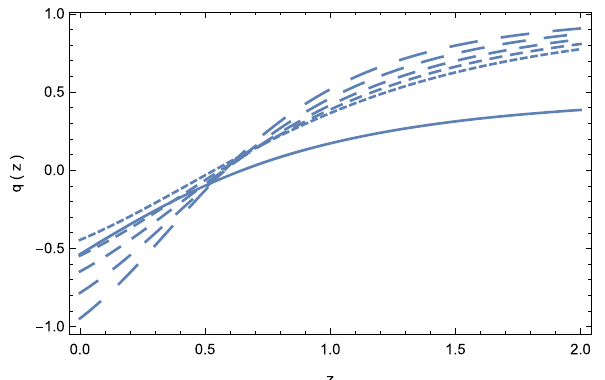
Fig. 4 VariationasafunctionoftheredshiftoftheLagrangemultiplier (cid:12) (cid:11) (cid:4)( z ) forthegeometry-mattercouplingfunction F ˜ Q , ˜ T = for α = − 1 . 95, M = 0 . 95, and for different values of β : β = − 2 . 64 (solid curve), β = − 2 . 78 (dotted curve), β = − 2 . 91 (short dashed curve), β = − 3 . 07(dashedcurve),and β = − 3 . 24(longdashedcurve). To integrate the system of cosmological evolution equations we have used the initial conditions h ( 0 ) = 1, (cid:18)( 0 ) = 0 . 555, and (cid:4)( 0 ) = 0 .